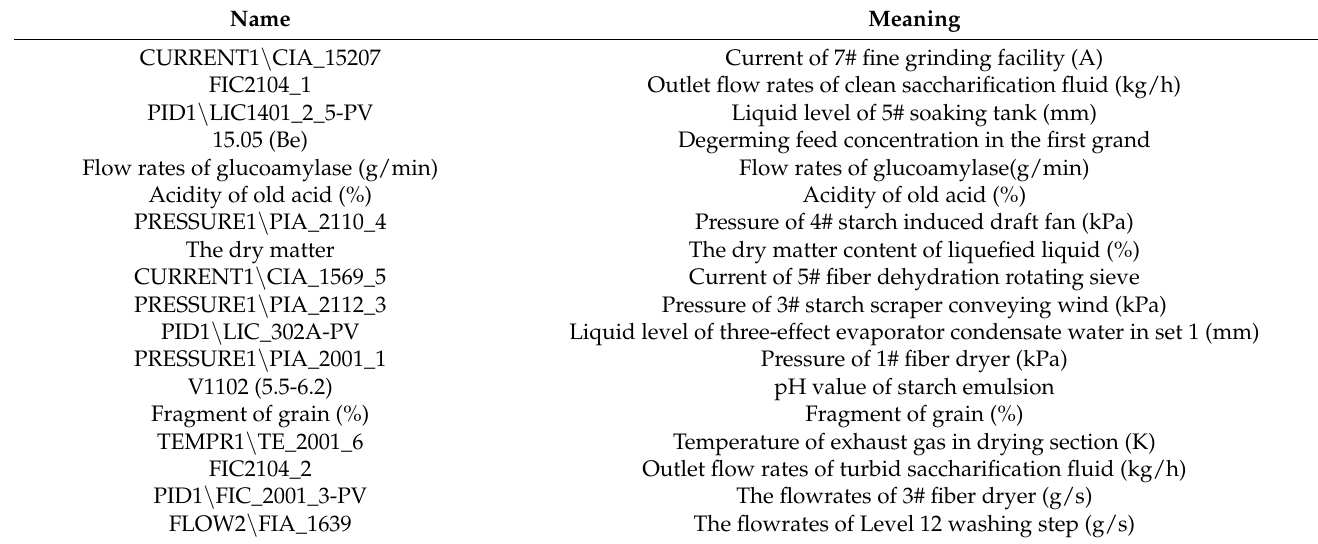
Table 1. The name and meaning of the top 18 selected